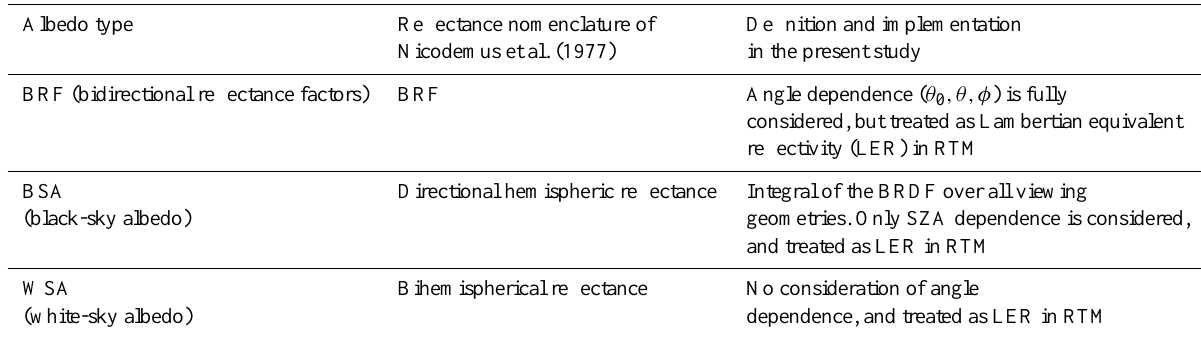
Table 1. Definition of surface albedo types used in the present study.